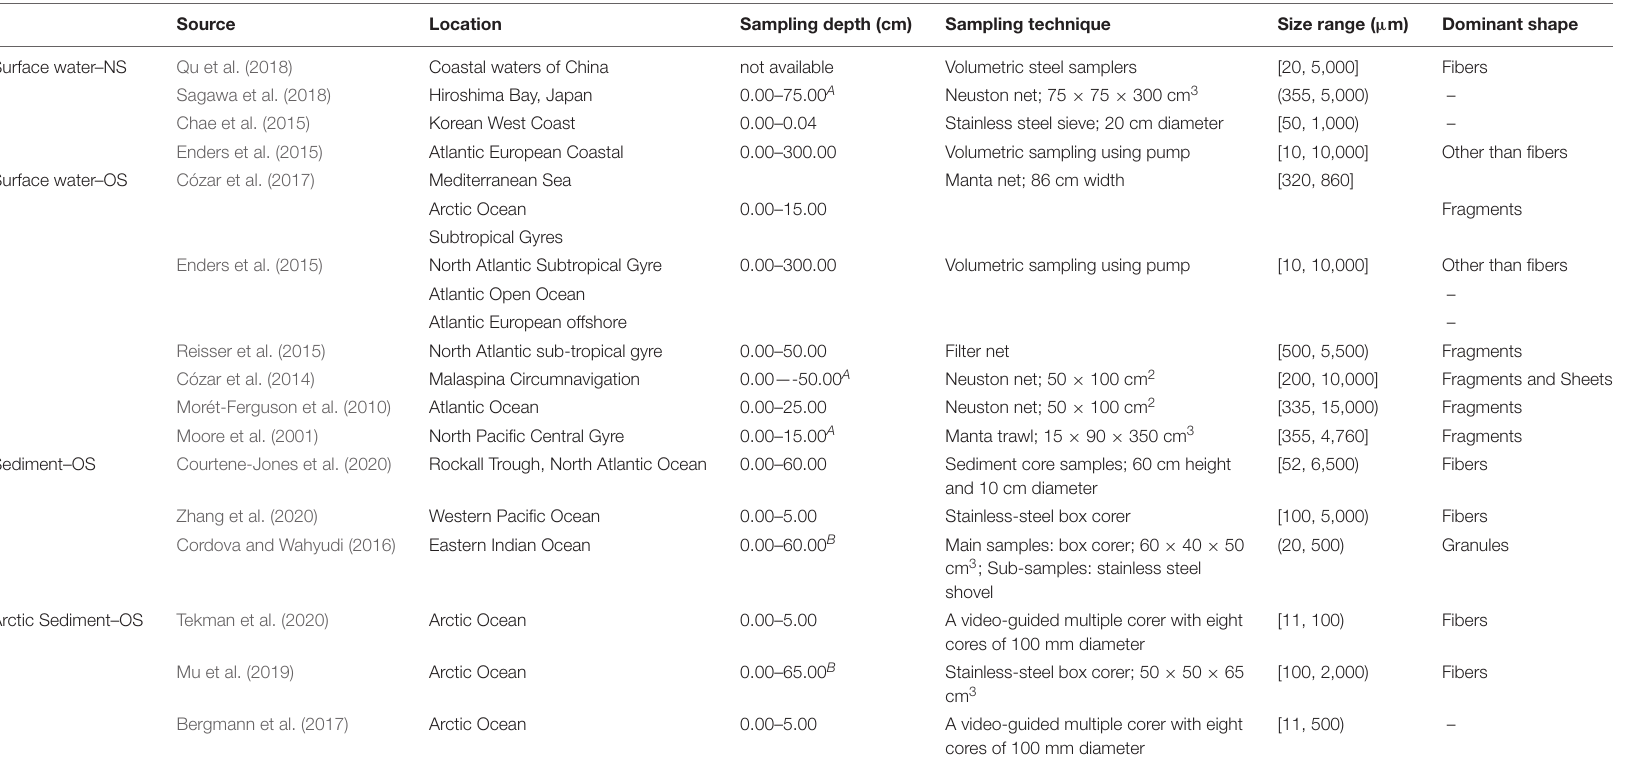
TABLE 2 | Studies that have identified the size distribution of MPs in nearshore (NS) and offshore (OS) water and offshore